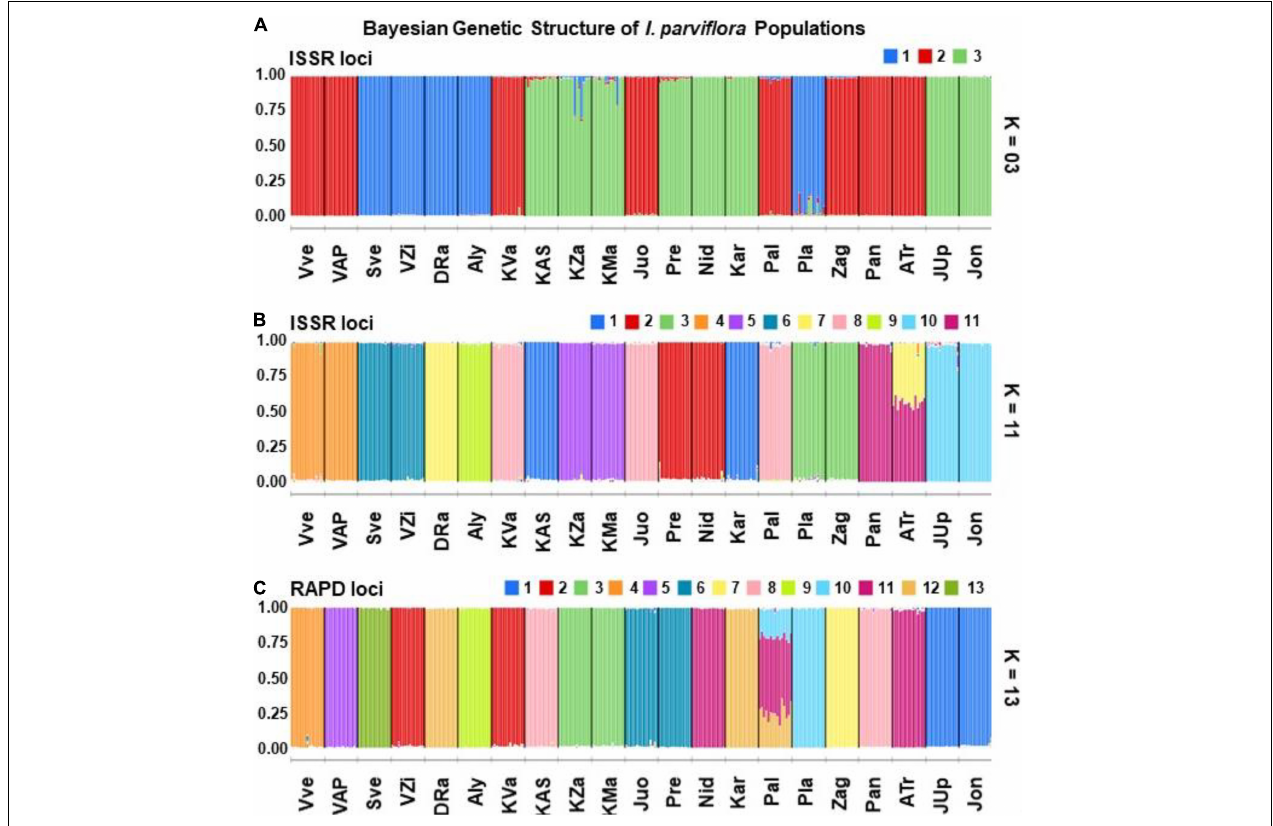
FIGURE 7 | Barplots of the membership of Impatiens parviflora individuals/populations from the 21 sites in each of K genetic clusters identified from the ISSR or RAPD datasets using the Bayesian clustering in the STRUCTURE: (A) ISSR ( K = 3, as next to the highest K); (B) ISSR ( K = 11, the highest K); (C) RAPD ( K = 13, the highest K). White lines separate bars of different individuals, black lines separate bars of different populations. Bars are partitioned into K colored segments that represent the individual’s/population’s estimated membership fractions (the amount of the genetic diversity) in K clusters. Three letters denote the populations (Pop) (for details of their locations, see Figure 1